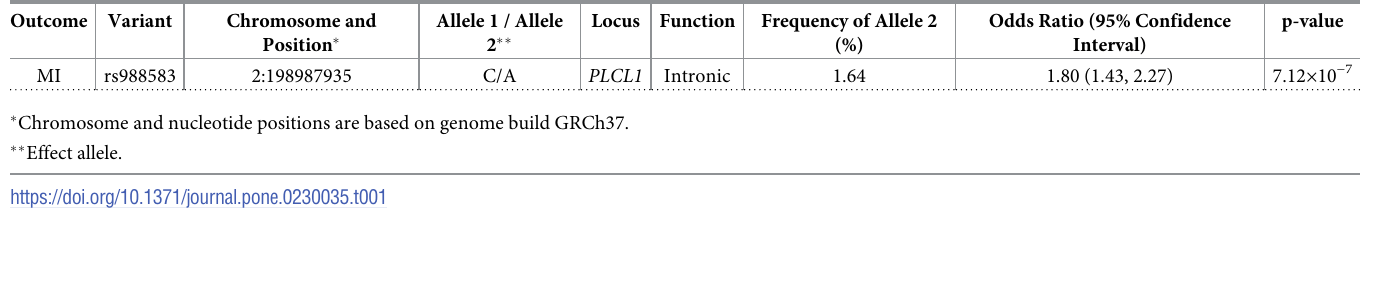
Table 1. Low-frequency variants associated with prevalent MI and